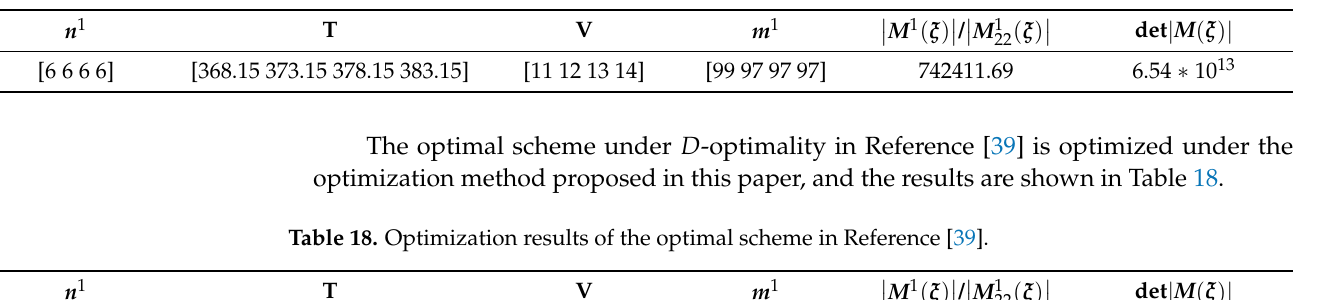
Table 17. Optimization results.